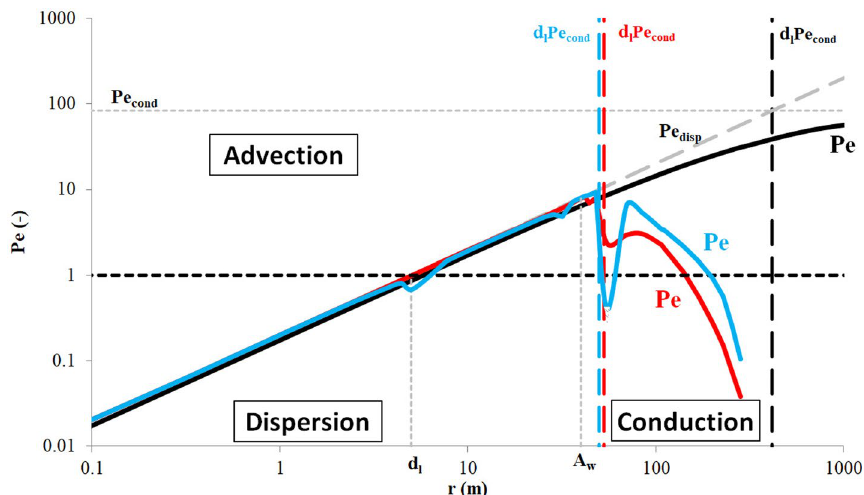
Fig. 5 Peclet number at the end of the injection (red colour) and at the end of the back injection (blue colour) in the first year of operation. Aw represents the auxiliary well. Black and grey lines represent the perfectly radial Peclet. Central well is located at 0 m and the auxiliary well is represented with A w